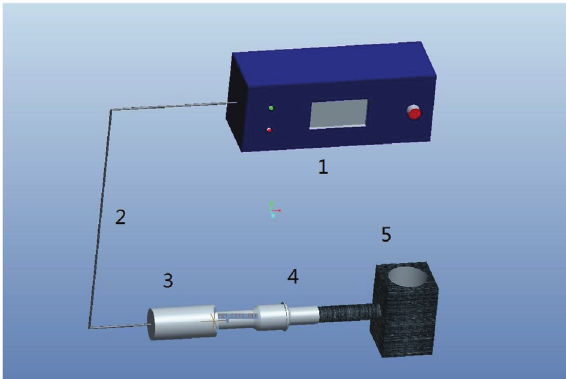
Figure 1: Sketch of ultrasonic experimental equipment.